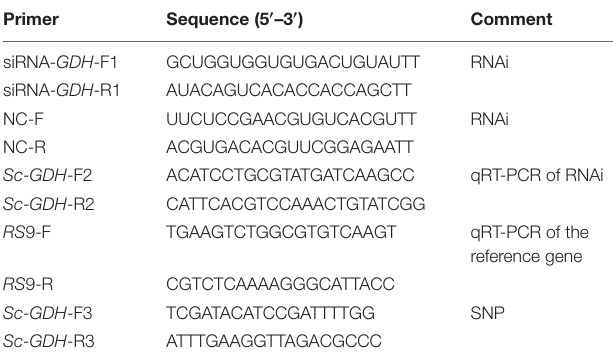
TABLE 1 | Primers and sequences of the